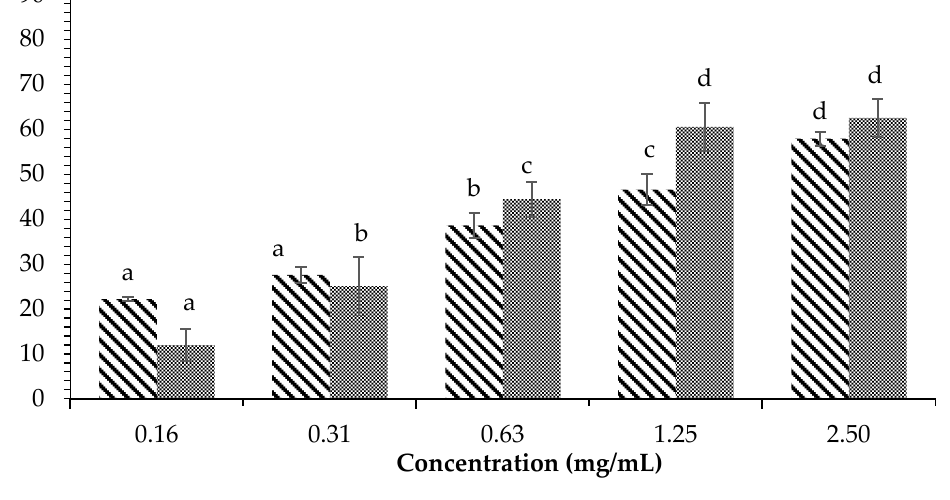
Concentration (mg/mL) Figure 3. Effects of concentration of water fraction of H. tuna ( ) and Acarbose ( ) on α -amylase Figure 3. Effects of concentration of water fraction of H. tuna ( Figure 3. Effects of concentration of water fraction of H. tuna ( ) and Acarbose ( ) on α -amylase ) on α -amylase Figure 3. Effects of concentration of water fraction of H. tuna ( ) and Acarbose ( ) on α -amylase inhibition. Each value is expressed as mean ± SD in the triplicate experiment. Values (a–d) with inhibition. Each value is expressed as mean ± SD in the triplicate experiment. Values (a–d) with inhibition. Each value is expressed as mean ± SD in the triplicate experiment. Values (a–d) with inhibition. Each value is expressed as mean ± SD in the triplicate experiment. Values (a–d) with different alphabet letters indicate significant differences among treatments at p < 0.05, which was different alphabet letters indicate significant differences among treatments at p < 0.05, which was different alphabet letters indicate significant differences among treatments at p < 0.05, which was different alphabet letters indicate significant differences among treatments at p < 0.05, which was analyzed using Tukey’s HSD. analyzed using Tukey’s HSD. analyzed using Tukey’s HSD. analyzed using Tukey’s HSD.